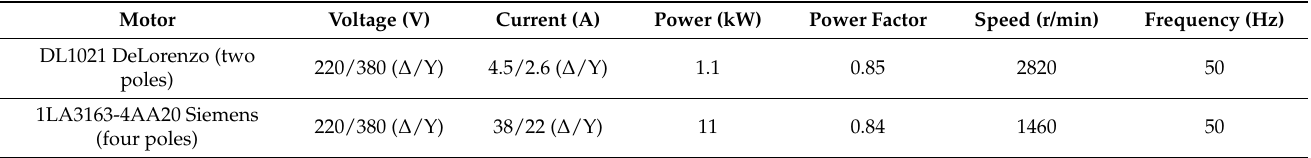
Table A1. Technical characteristics of the induction motor used in the tests.